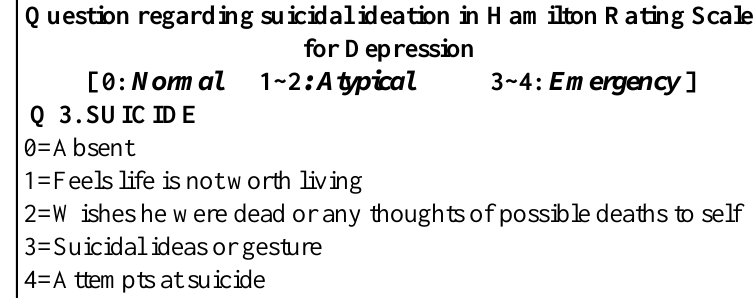
Figure 1. Question Number 3 of the Hamilton Rating Scale for